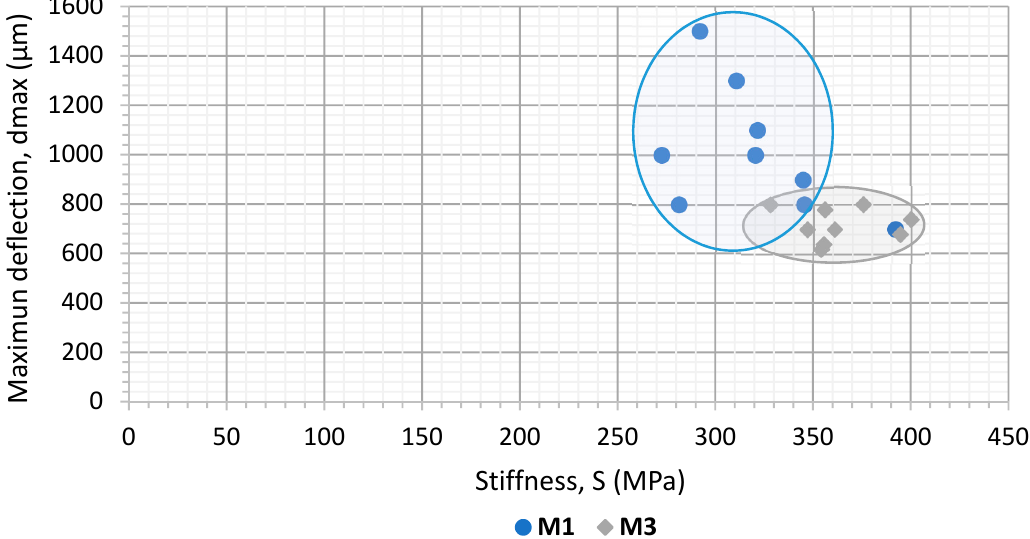
Figure 6. Results of stiffness and maximum deflection measured the mortars with cement active filler. M1 conventional binder M3 modified binder.